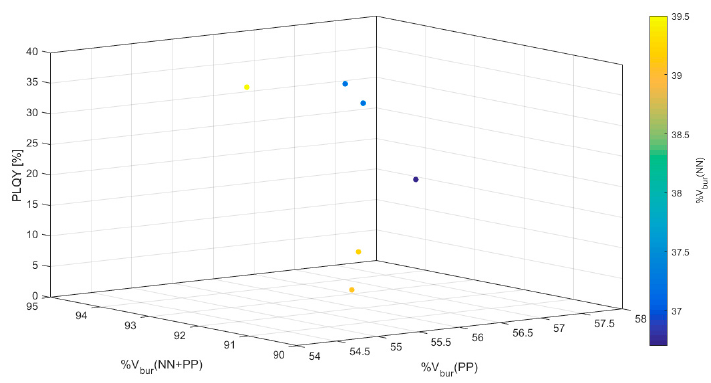
Figure 11. 3-Dimensional scatter plot with color-coded %V bur (NN) for compounds 13 – 18 [18].